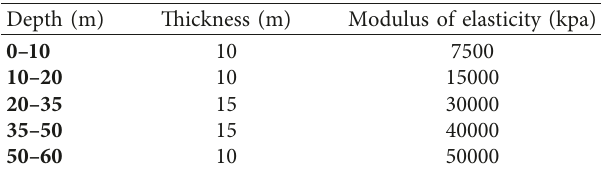
Table 1: Modulus of elasticity versus depth for Dehli subway soil [32].